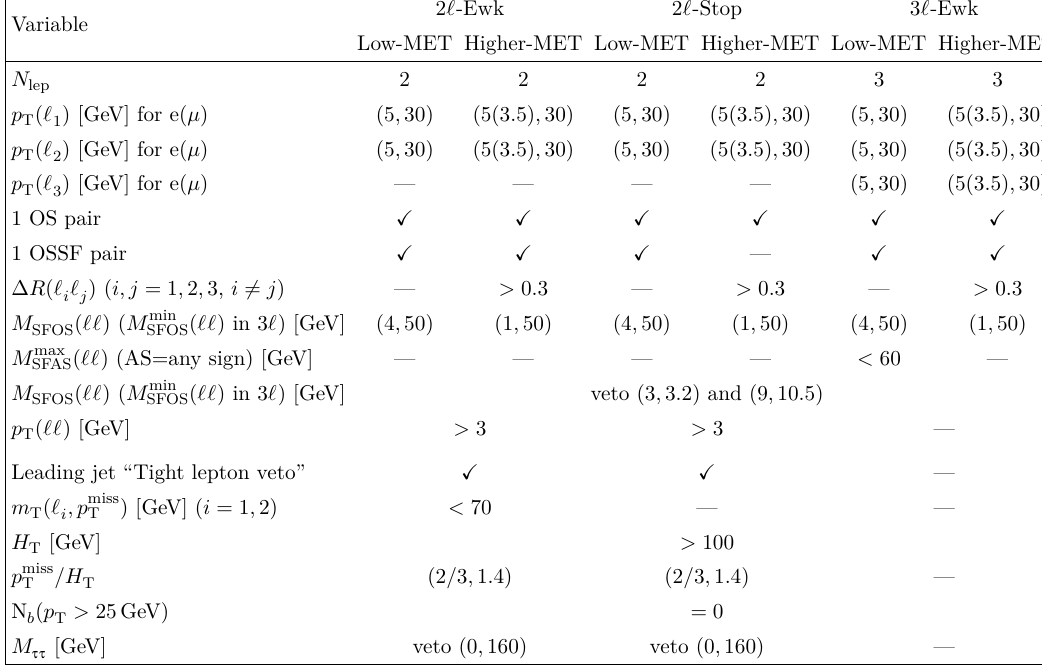
Table 2 . List of all criteria that events must satisfy to be selected in one of the SRs. The label “Low-MET” refers to the low-MET bin of the analysis, while the label “Higher-MET” refers collectively to the Med-, High- and Ultra-MET bins of the